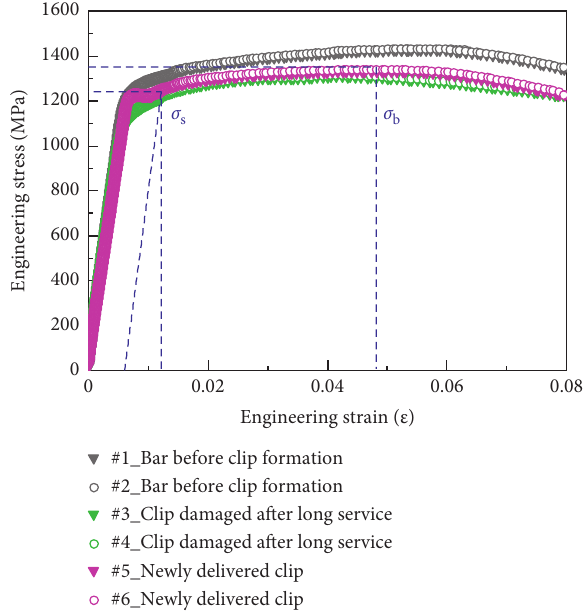
Figure 9: The uniaxial tensile test results on the clip material 38Si7 (engineering stress-strain curve). Table 3: Tensile properties of the clip material 38Si7 (mean